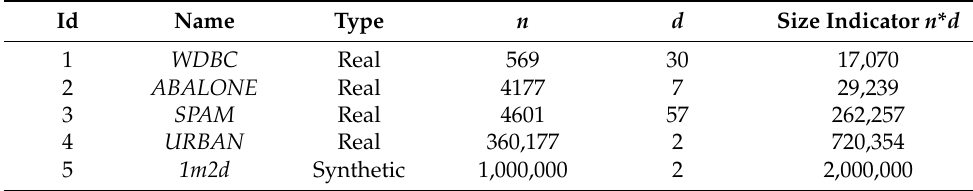
Table 1. Datasets used in